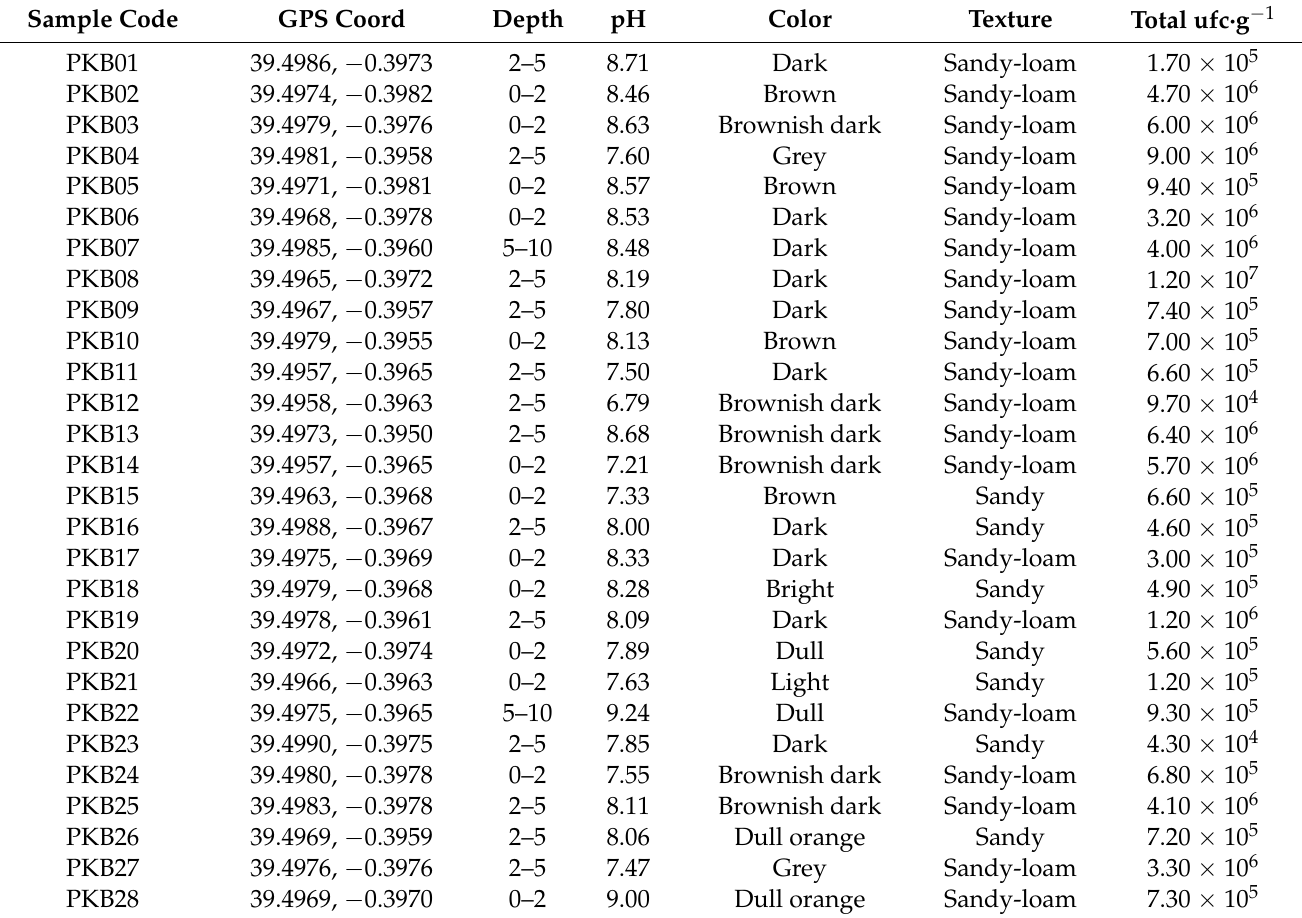
Table 1. Geo-location and basic soil